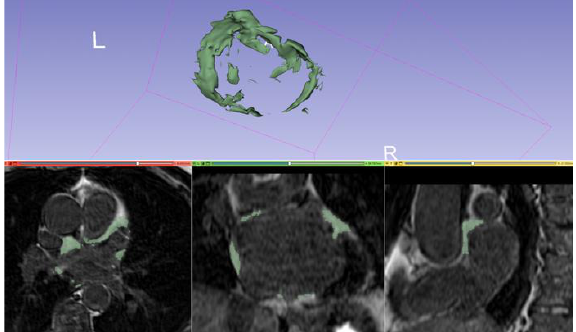
Figure 8. Manual segmentation of periatrial fat and volume rendering on a 3D IR spoiled gradient echo LGE acquisition with 3DSlicer (slicer.org, accessed on 10 June